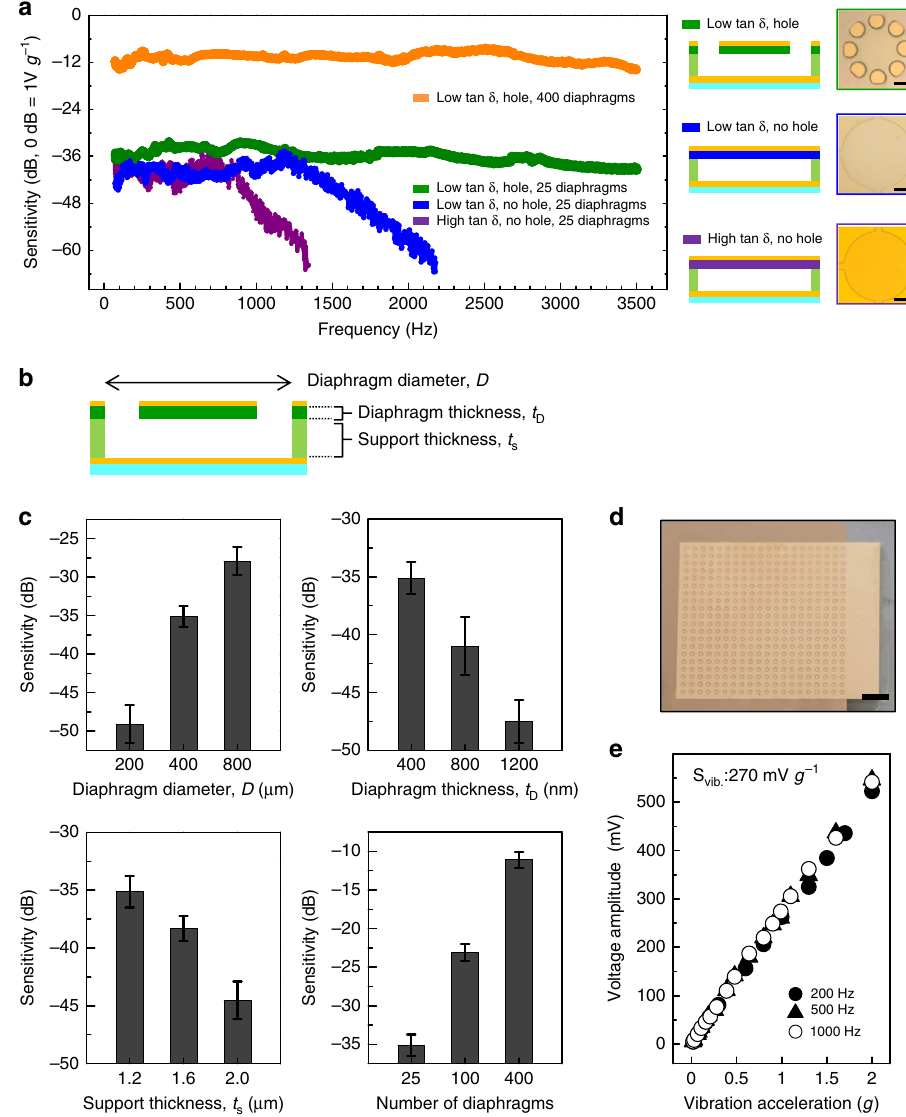
Fig. 2 Effects of material and structure on the device performance. a Frequency response data for the devices with different material, structure, and number of diaphragms. The zero decibel line corresponds to a response of 1 V g − 1 . Optical microscope images (Scale bars: 100 μ m) and cross-sectional schematic drawings of diaphragms are shown in the right. b The schematic shows the cross-sectional structure of a diaphragm with air holes and its structural parameters. c Effects of diaphragm diameter; diaphragm thickness; support thickness; and the number of diaphragms on the vibrational sensitivity. For each graph, low tan δ polymer was used for the diaphragm material, air holes were patterned on the diaphragm, and the structural parameters were fi xed as follows unless speci fi ed: diaphragm diameter of 400 μ m, diaphragm thickness of 400 nm, support thickness of 1.2 μ m and an array of 25 diaphragms. The error bars represent the s.d. of the sensitivity values for the measured frequencies. d , e Microscope image (Scale bar: 2 mm) ( d ) and output data ( e ) of an optimized device: an array of 400 low tan δ polymer diaphragms with air holes on 2 cm 2